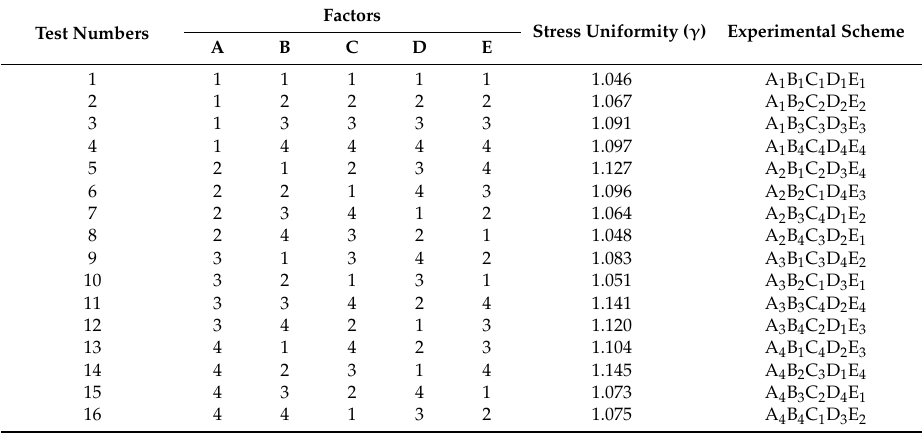
Table 6. Orthogonal table and simulation results (100 MPa).